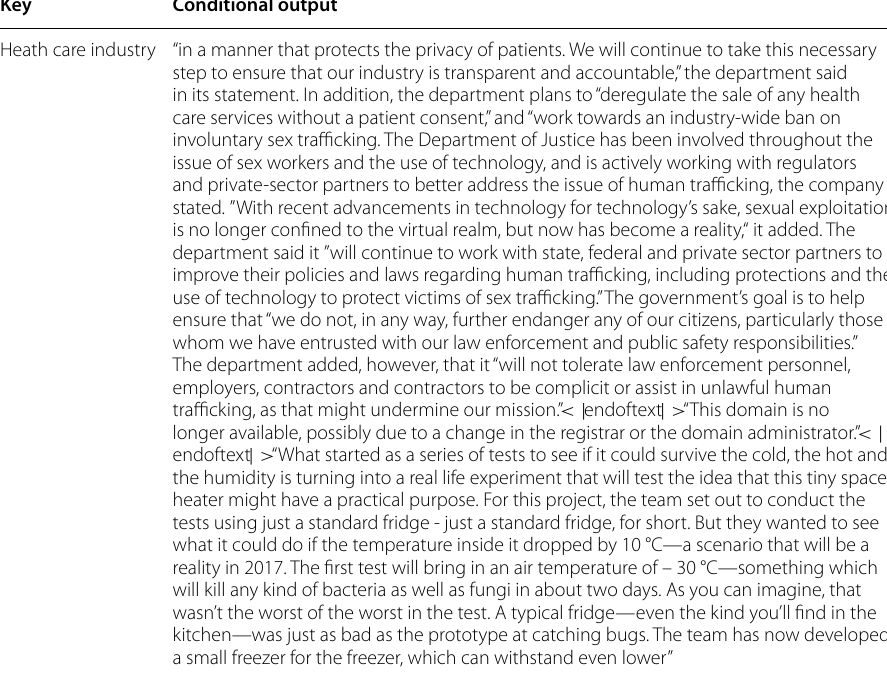
Table 6 Results of interactive conditional samples